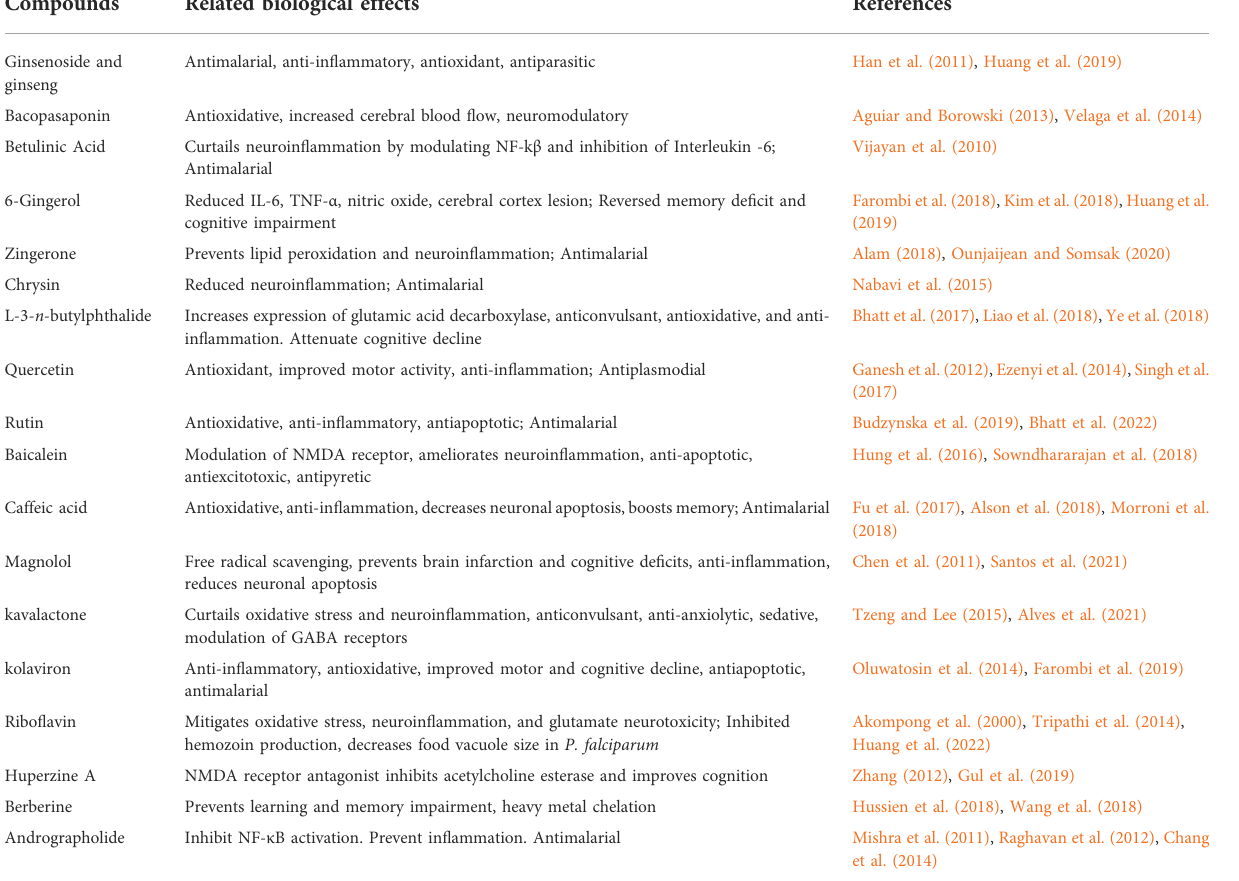
TABLE 2 Some medicinal plants ’ derived compounds with neuroprotective and/or antimalarial